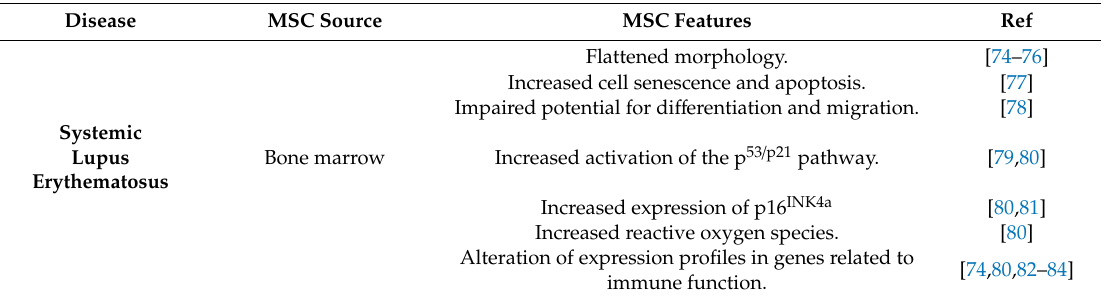
Table 4. MSC dysfunction in